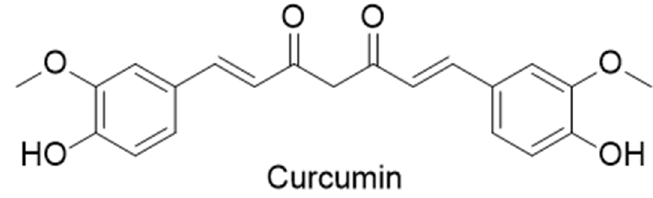
Figure 1. Chemical structure of